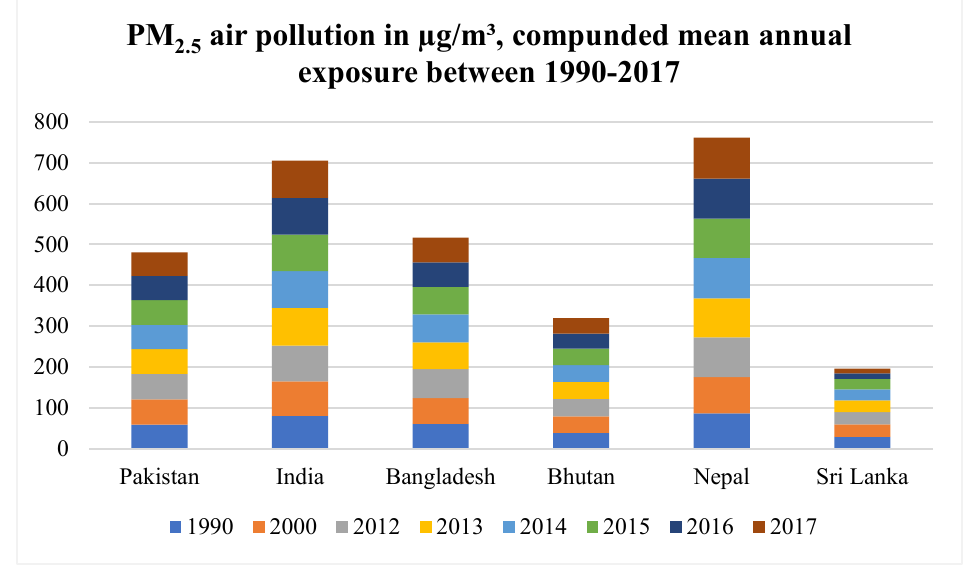
Figure 3. Population-weighted exposure to ambient PM 2.5 pollution expressed in µg/m 3 [16].